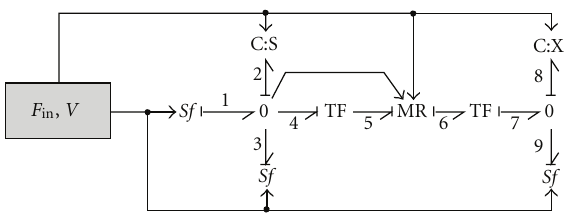
Figure 1: Pseudo bond graph model of the fed-batch prototype bioprocess. The directions of half arrows correspond to the run of the reaction, from the substrate S towards biomass X . The mass balances are represented by two 0-junctions: 0 1,2,3,4 (for S ), and 0 7,8,9 (for X ). Mass flows of entering/exiting components are modeled using modulated source flows Sf . The reaction rate is modeled by a modulated two port R element, denoted MR 5,6 . F in is the input feed rate ( l/h ) and V the bioreactor volume